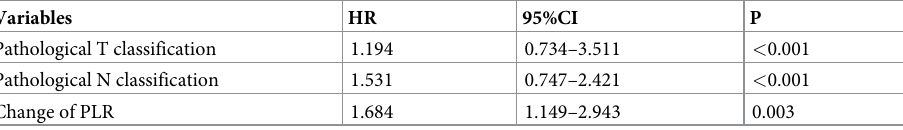
Table 3. Factors associated with postoperative recurrence in the multivariate analyses.